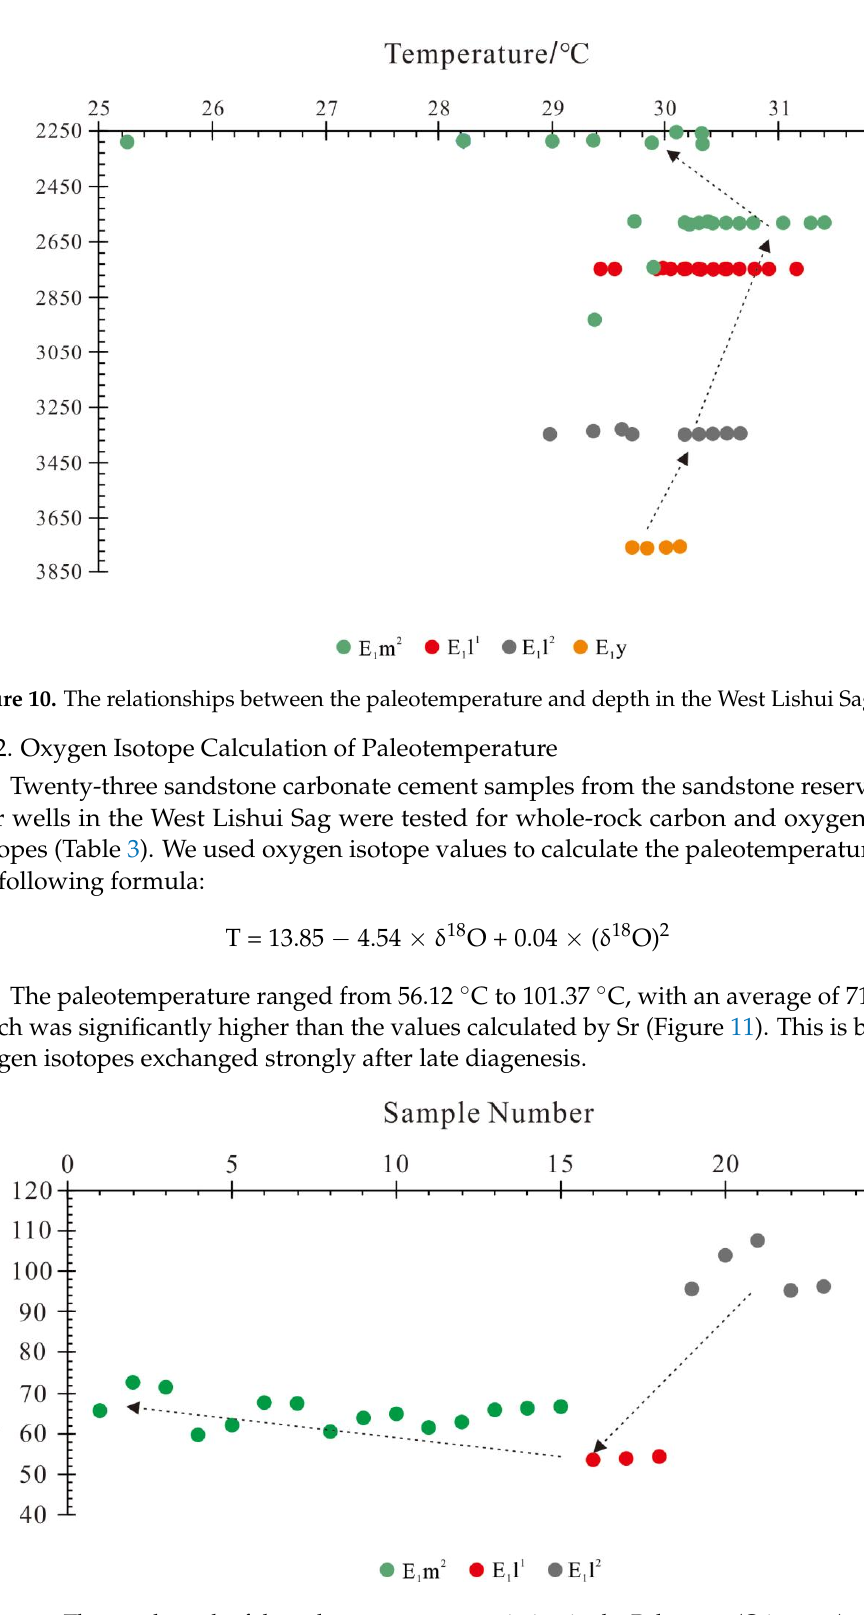
Figure 11. The trend graph of the paleotemperature variation in the Paleocene (O isotope).